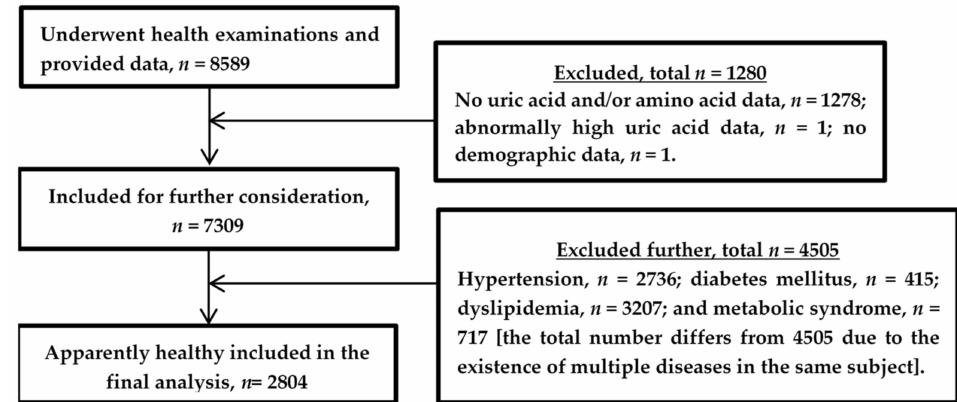
Figure 1. Flowchart of current study